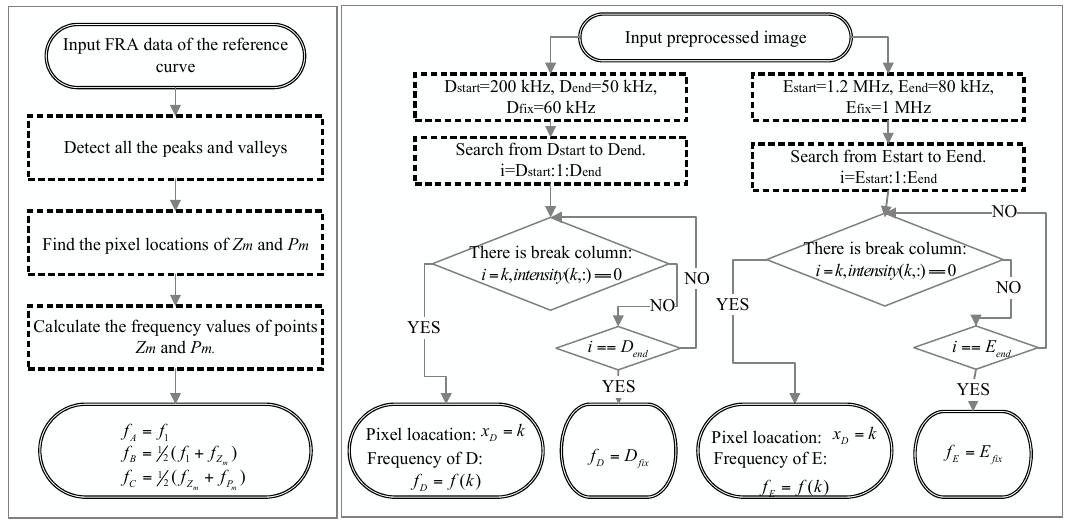
Figure 4. Strategic flowchart of the algorithm for the determination of frequency sub-band boundaries.